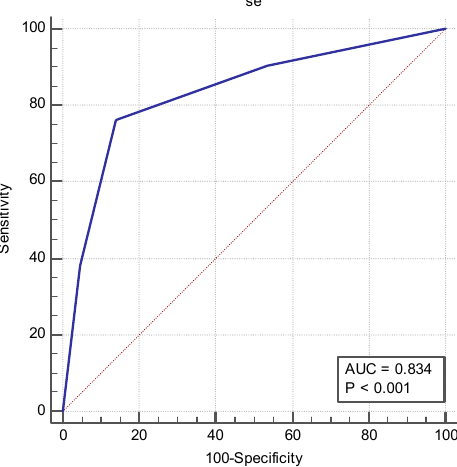
Figure 3. The area under the receiver operating characteristic (AUROC) curve for elastography in the evaluation of cases with Bethesda III and IV cytology compared to the pathology report. When analyzing the group of malignant lesions, a considerable majority (16/21) displayed an elastogram illustrating increased stiffness. Five cases had low stiffness: three follicular neoplasia with unclear prognosis, one papillary cancer, and one follicular cancer.